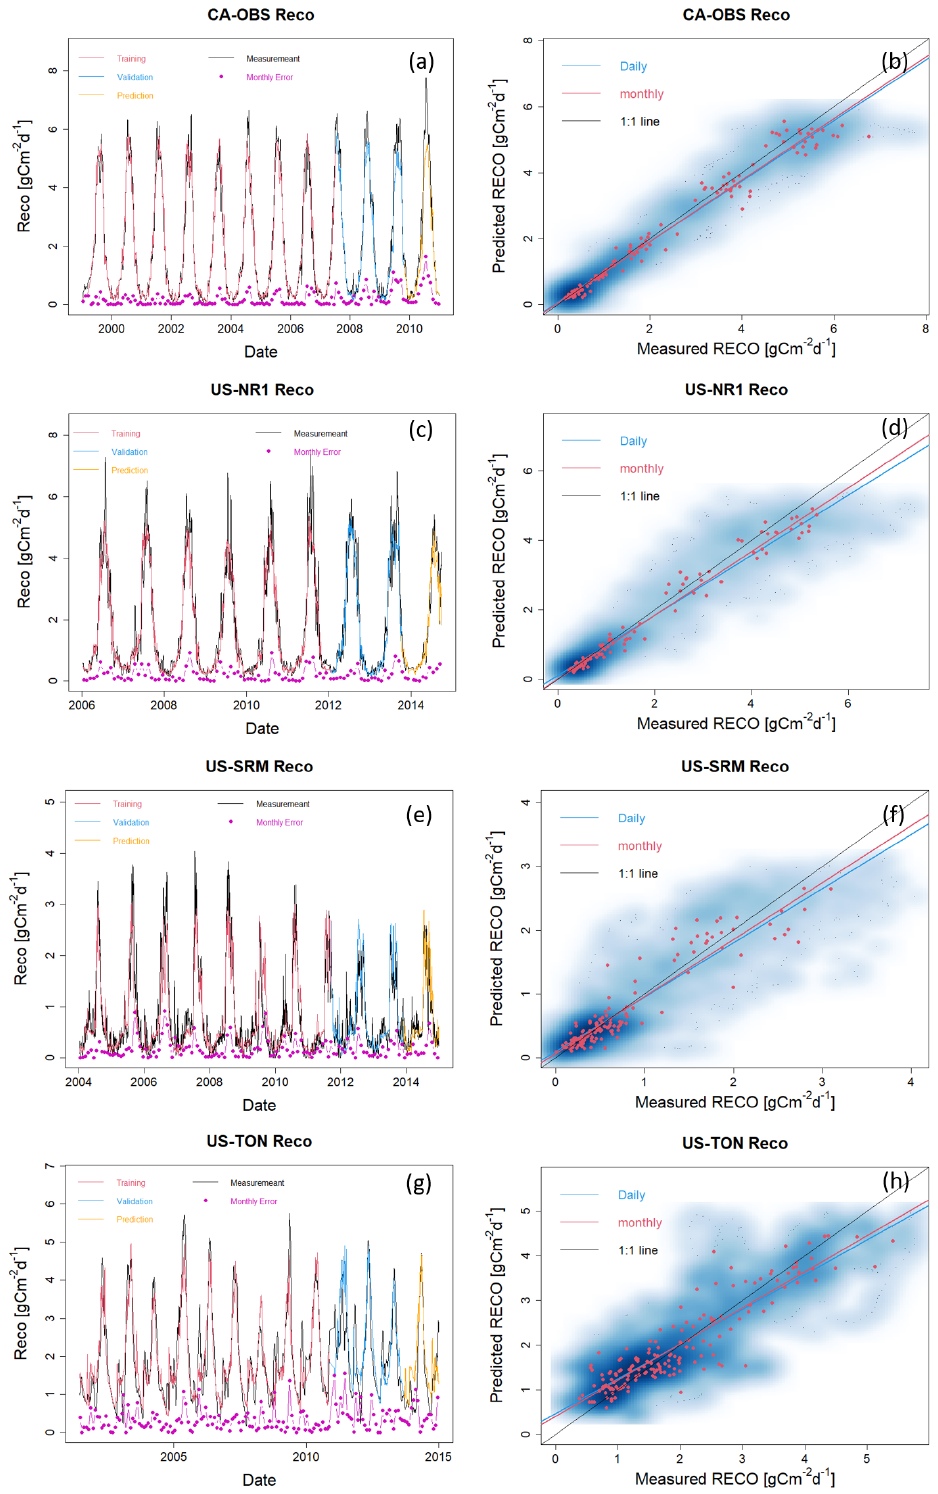
Figure A3. R eco estimation with data from selected FLUXNET sites at CA-OBS, US-NR1, US-SRM, and US-Ton. Panels (a) , (c) , (e) , and (g) present daily estimations of R eco separated for training, validation, and prediction. Pink points depict monthly error between HPM estimation and FLUXNET data. Panels (b) , (d) , (f) , and (h) show the scatter plots of daily (blue) and monthly (red) R eco . Darker blue clouds represent a greater density of data